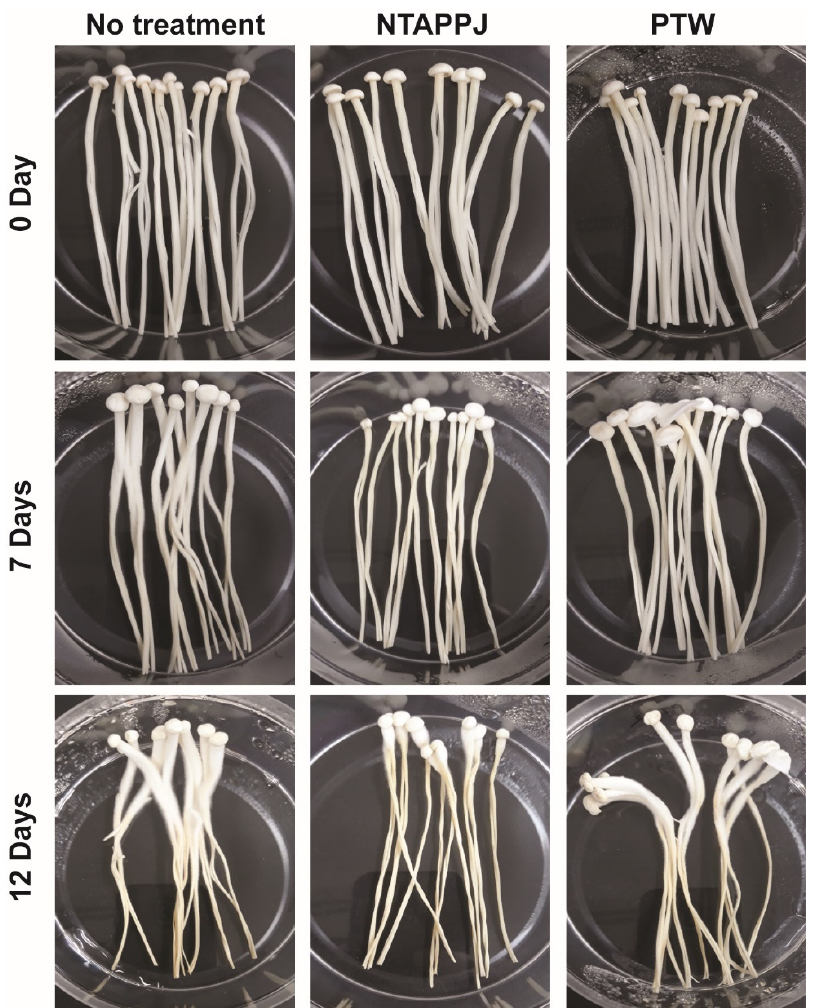
Figure 7. Appearance of F. velutipes mushrooms stored at 4 °C for 7 and 12 days.